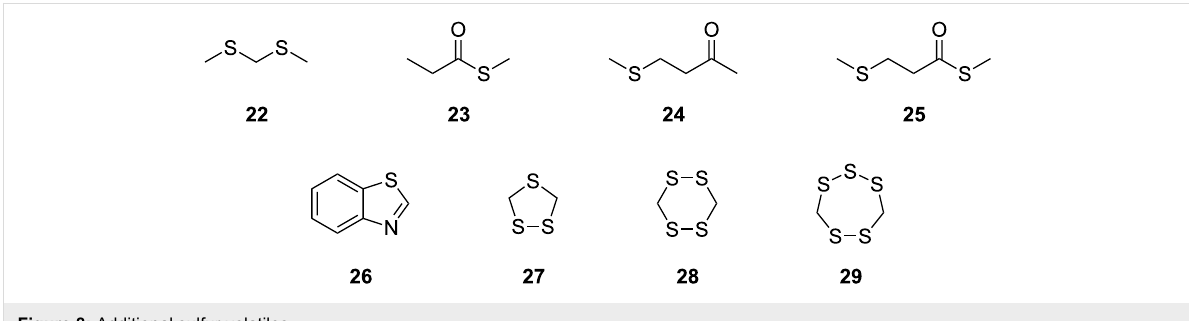
Figure 8: Additional sulfur volatiles.